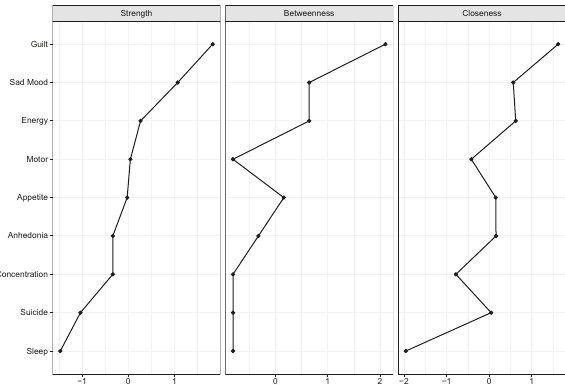
Fig. 2 Centrality measures of all symptoms within the network. The fi gure shows centrality measure (i.e., strength, betweenness, and closeness) of all factors within the network ( z